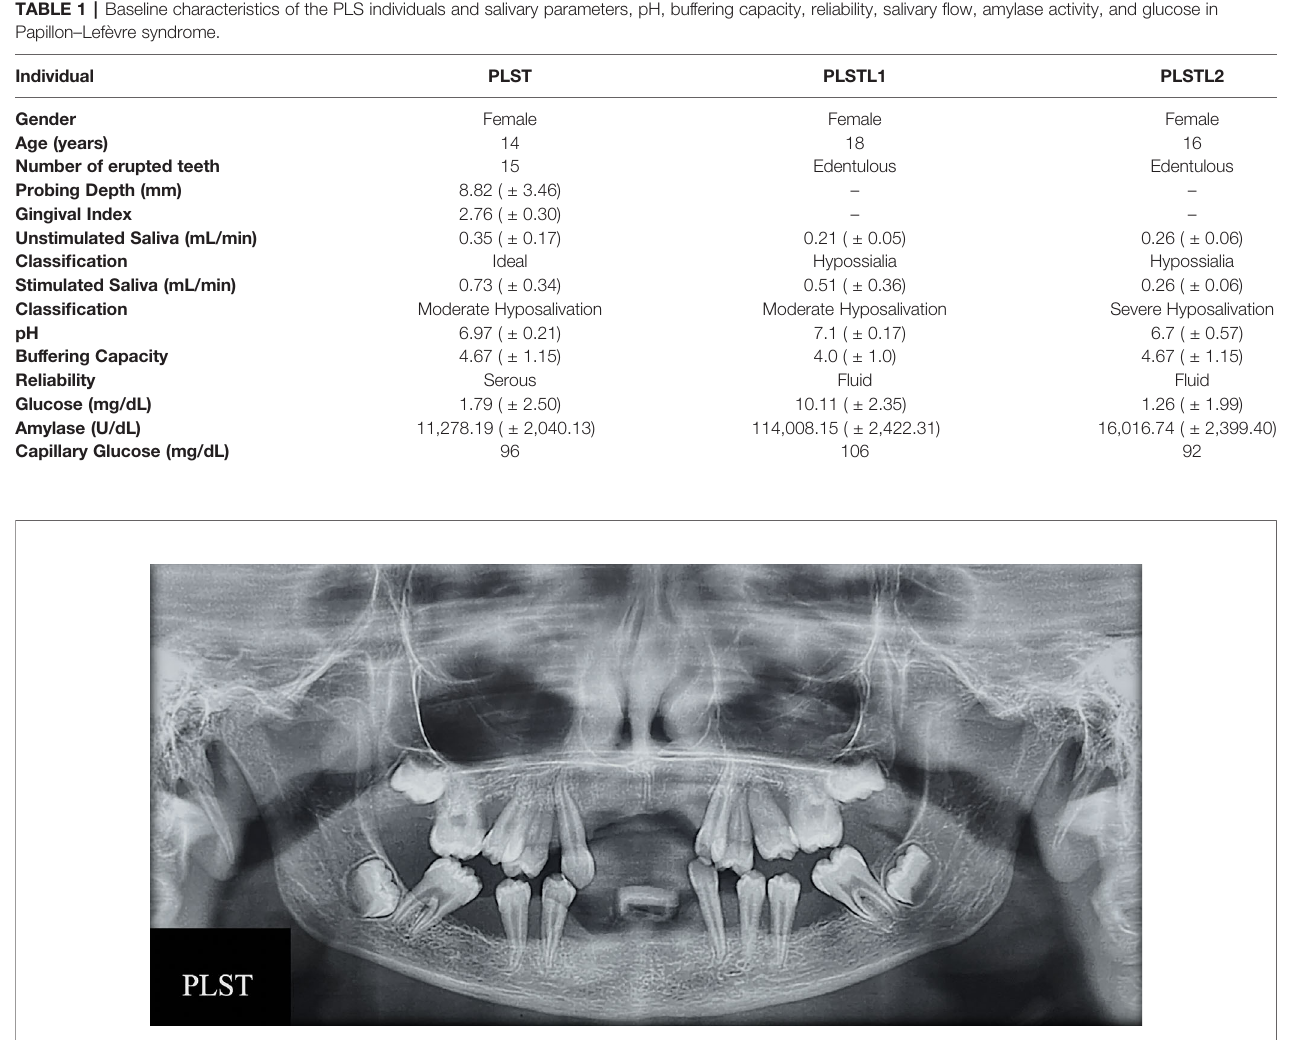
FIGURE 2 | RX exam of patient Papillon – Lefèvre syndrome toothed (PLST) showing bone loss and the appearance of teeth “ fl oating ”